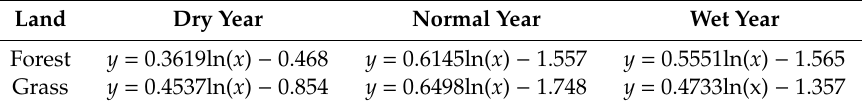
Table 4. The reduction function of runo ff by forestland and grassland.